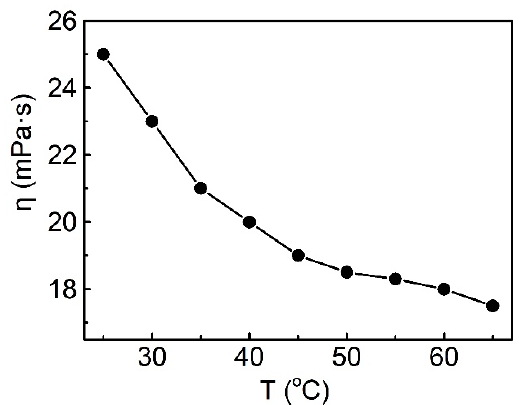
Figure 7. The effect of temperature on the viscosity reduction performance of OA and cyclen. The total concentration of OA and cyclen (molar ratio = 4:1) was 3.0 wt%, and the mass ratio of oil and OA/cyclen aqueous solution was set as 7:3.